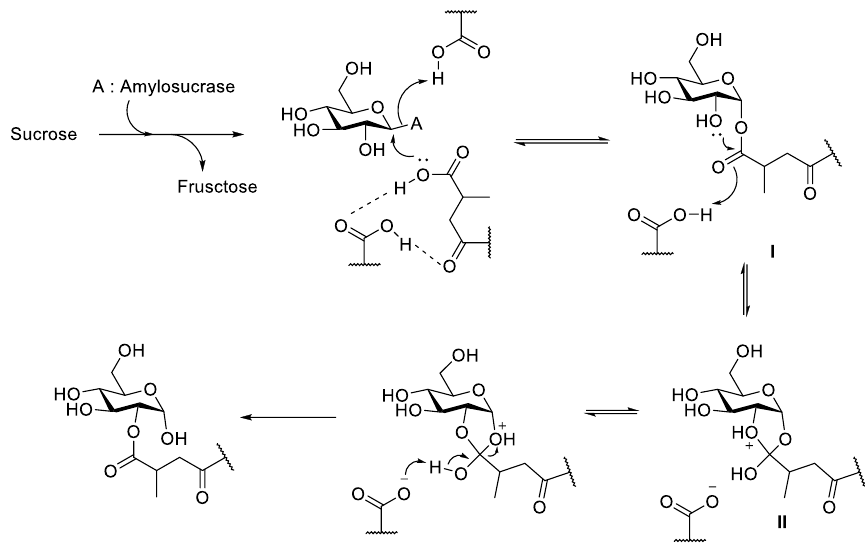
Figure 6. Proposed reaction mechanism of Dg AS toward ganoderic acids.